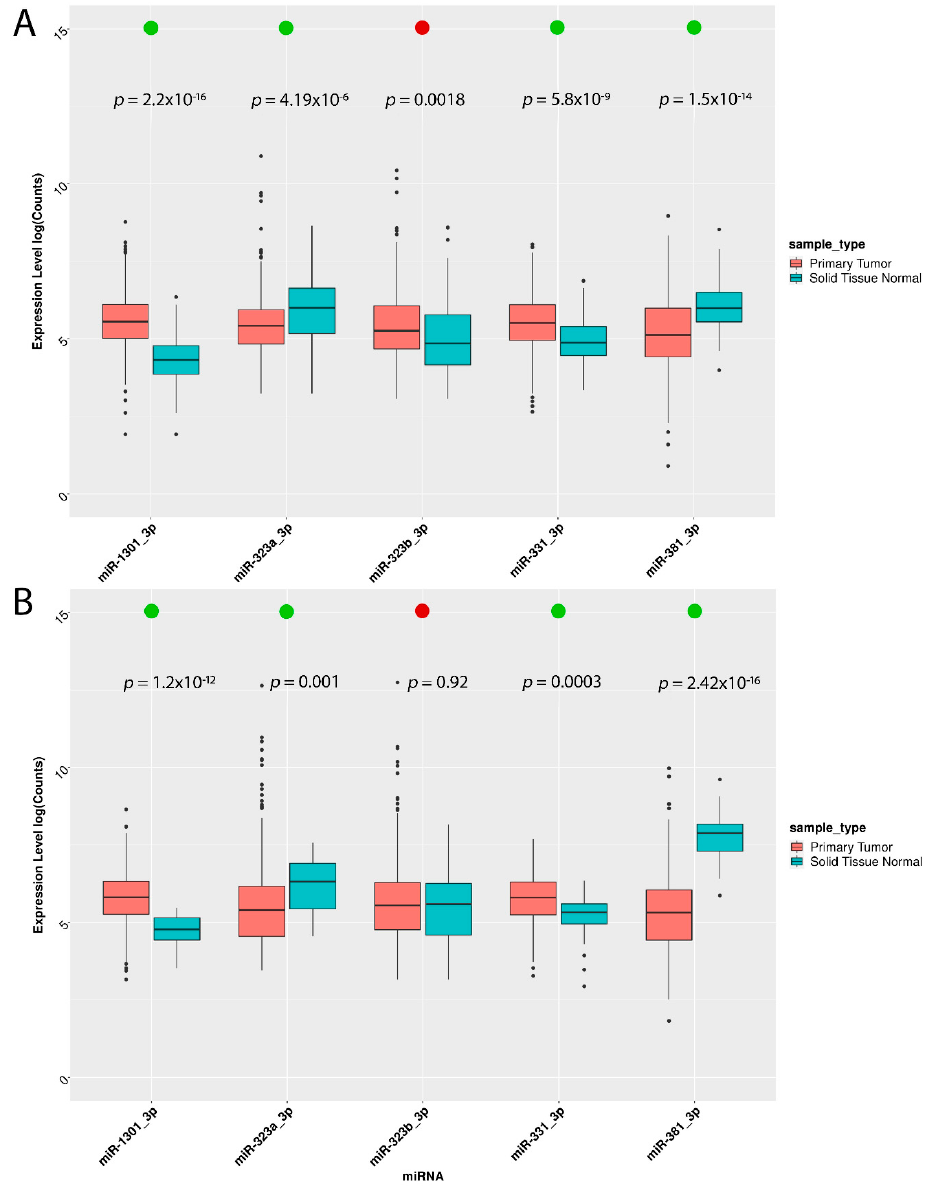
Figure 4. Comparison of miRNA expression between TCGA tissues and cell lines used in vitro. ( A ) TCGA miRNA expression (log scale) of breast invasive carcinoma ( n = 1096) and solid tissue normal ( n = 104) compared with relative expression in breast cell lines (MCF7 and T47D) and normal tissue cell line (MCF10A). ( B ) TCGA miRNA expression (log scale) of uterine corpus endometrial carcinoma ( n = 545) and solid tissue normal ( n = 33) compared with relative expression in endometrial cancer cell lines (MFE-280 and EN) and normal (HESC). The trend concordance in tissue/cell lines is indicated by the green dot, and non-concordance is indicated by the red dot. Statistically significant tumor/normal differences ( p -value < 0.05, Wilcoxon test).